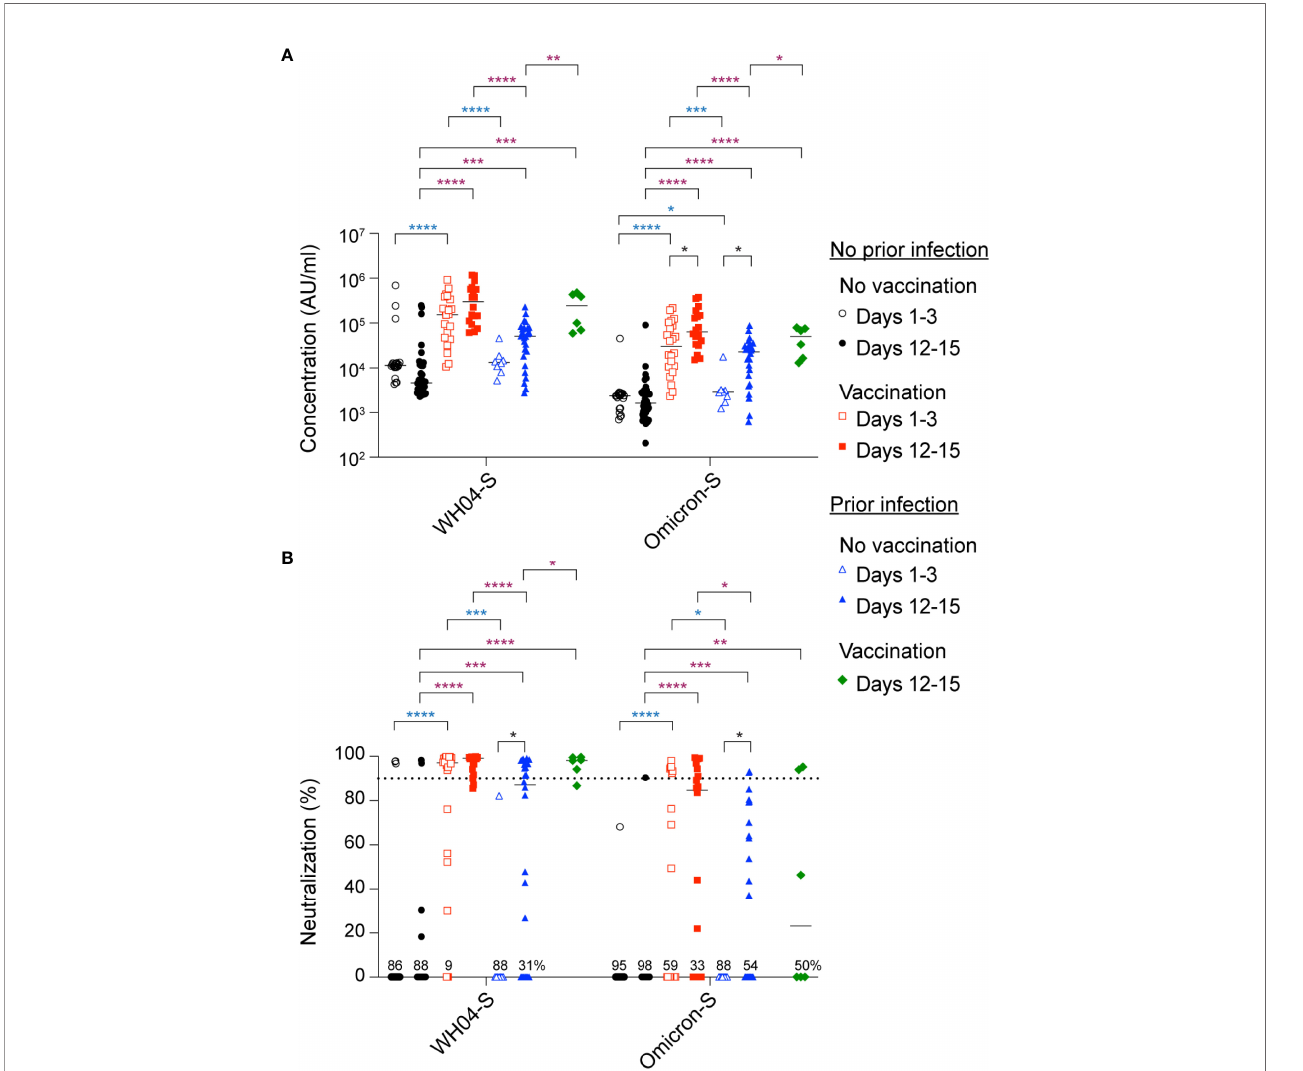
FIGURE 2 | Antibody analysis. (A) Plasma IgG antibody binding the SARS-CoV-2 RBD (spike) from the ancestral and Omicron strains in the unvaccinated and vaccinated Omicron patients without or with prior infection experience. (B) Neutralization response to virus spike protein of the ancestral and Omicron variants. p - value between two groups is from one-tailed Mann-Whitney t-test. Black asterisks indicate signi fi cance between days within the same group, blue asterisks indicate signi fi cance between groups (range of group means days1-3), purple asterisks indicate signi fi cance between groups (range of group means days 12-15). Percentage of samples with zero neutralization activity for each group are indicated over the X axis. * p < 0.05, ** p < 0.01, *** p < 0.001, **** P < 0.0001. Line at median, dotted line at